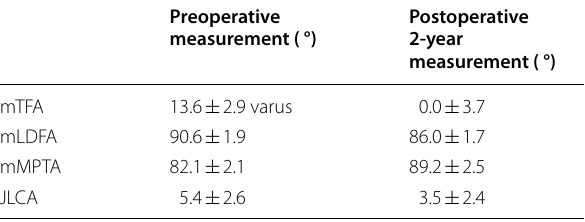
Table 2 Pre- and postoperative radiological parameter values for alignment and geometry of the